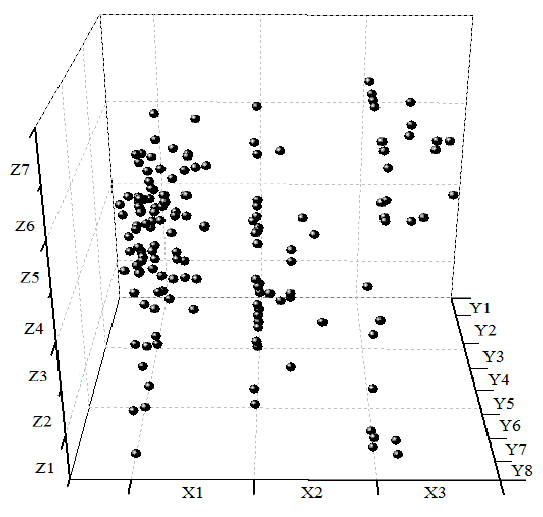
Figure 7. 156 accident points.